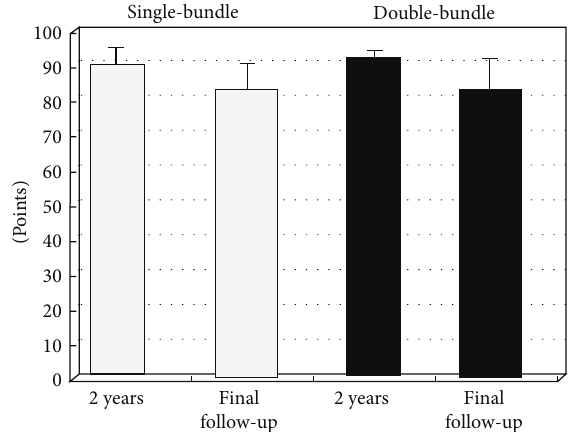
Figure 3: This graph shows the Lysholm scores. There were no sig- nificant differences between single- and double-bundle procedures or between results at 2 years and > 10 years. The error bars show SD.